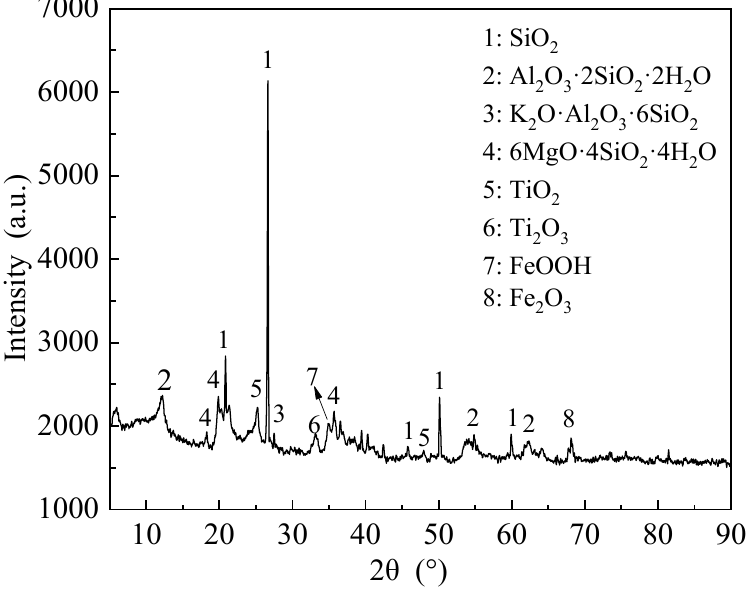
Figure 5. X-ray diffraction pattern of original test soil.